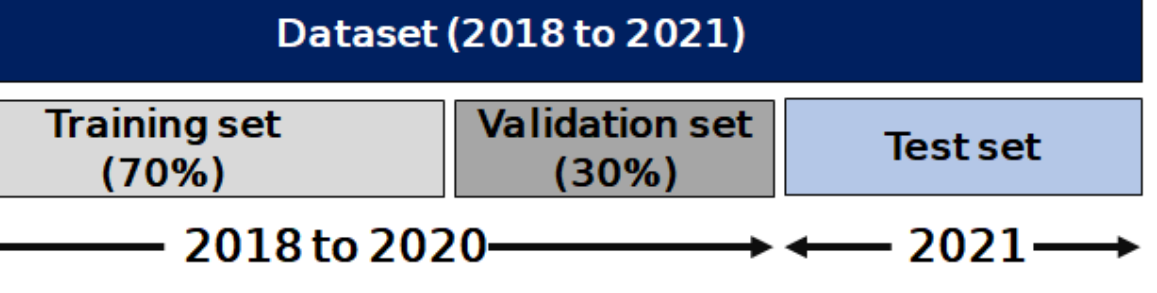
Figure 4. Division of dataset: training, validation, and test sets.